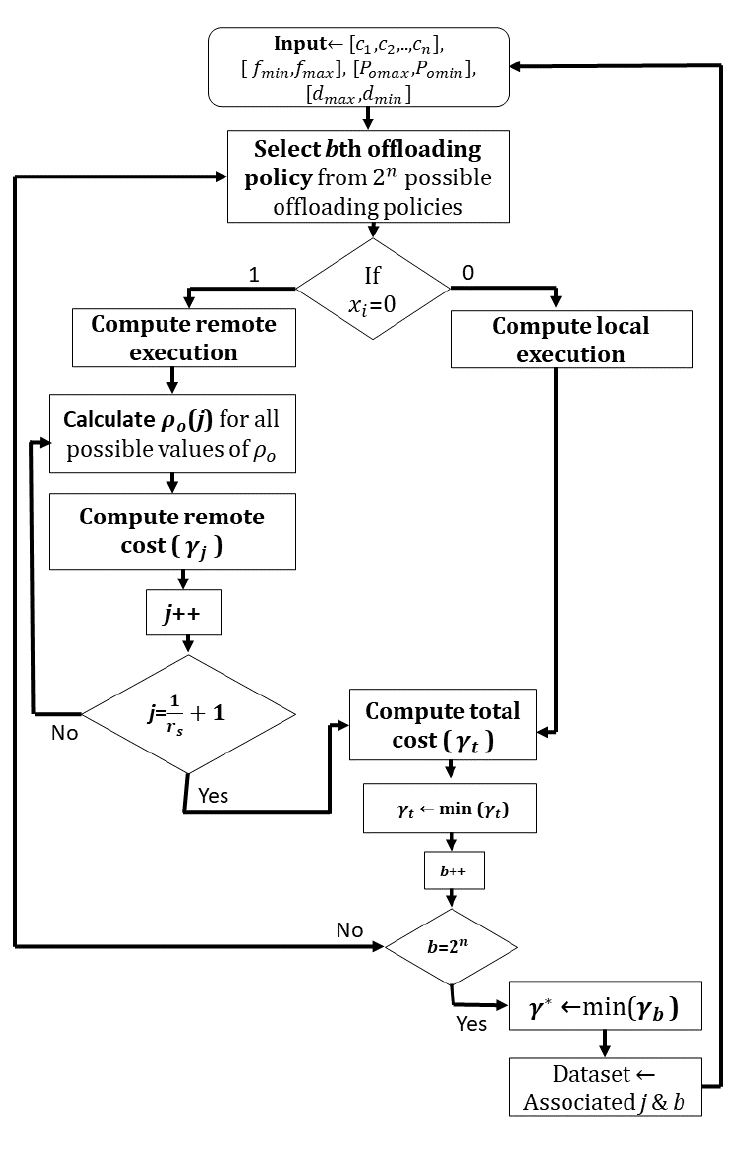
Figure 2. Flowchart of